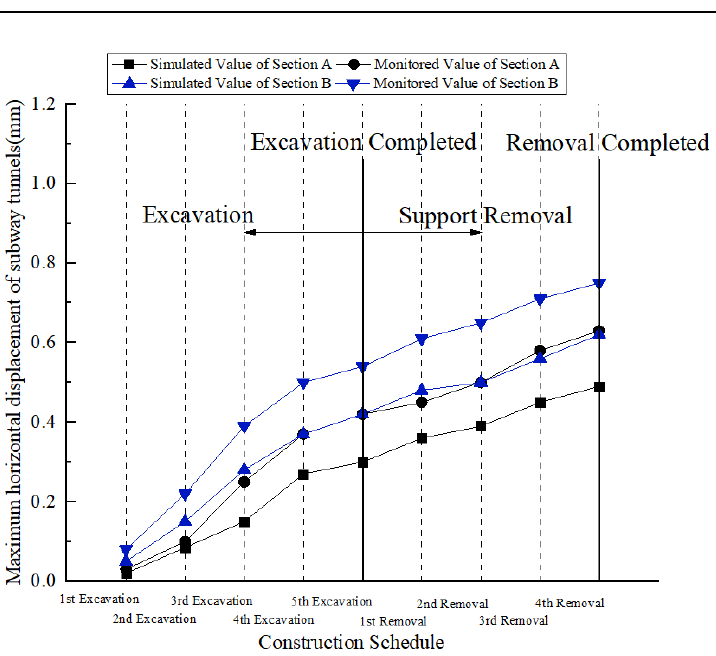
Figure 13. Maximum horizontal deformation of subway tunnel caused by foundation pit construc- tion.